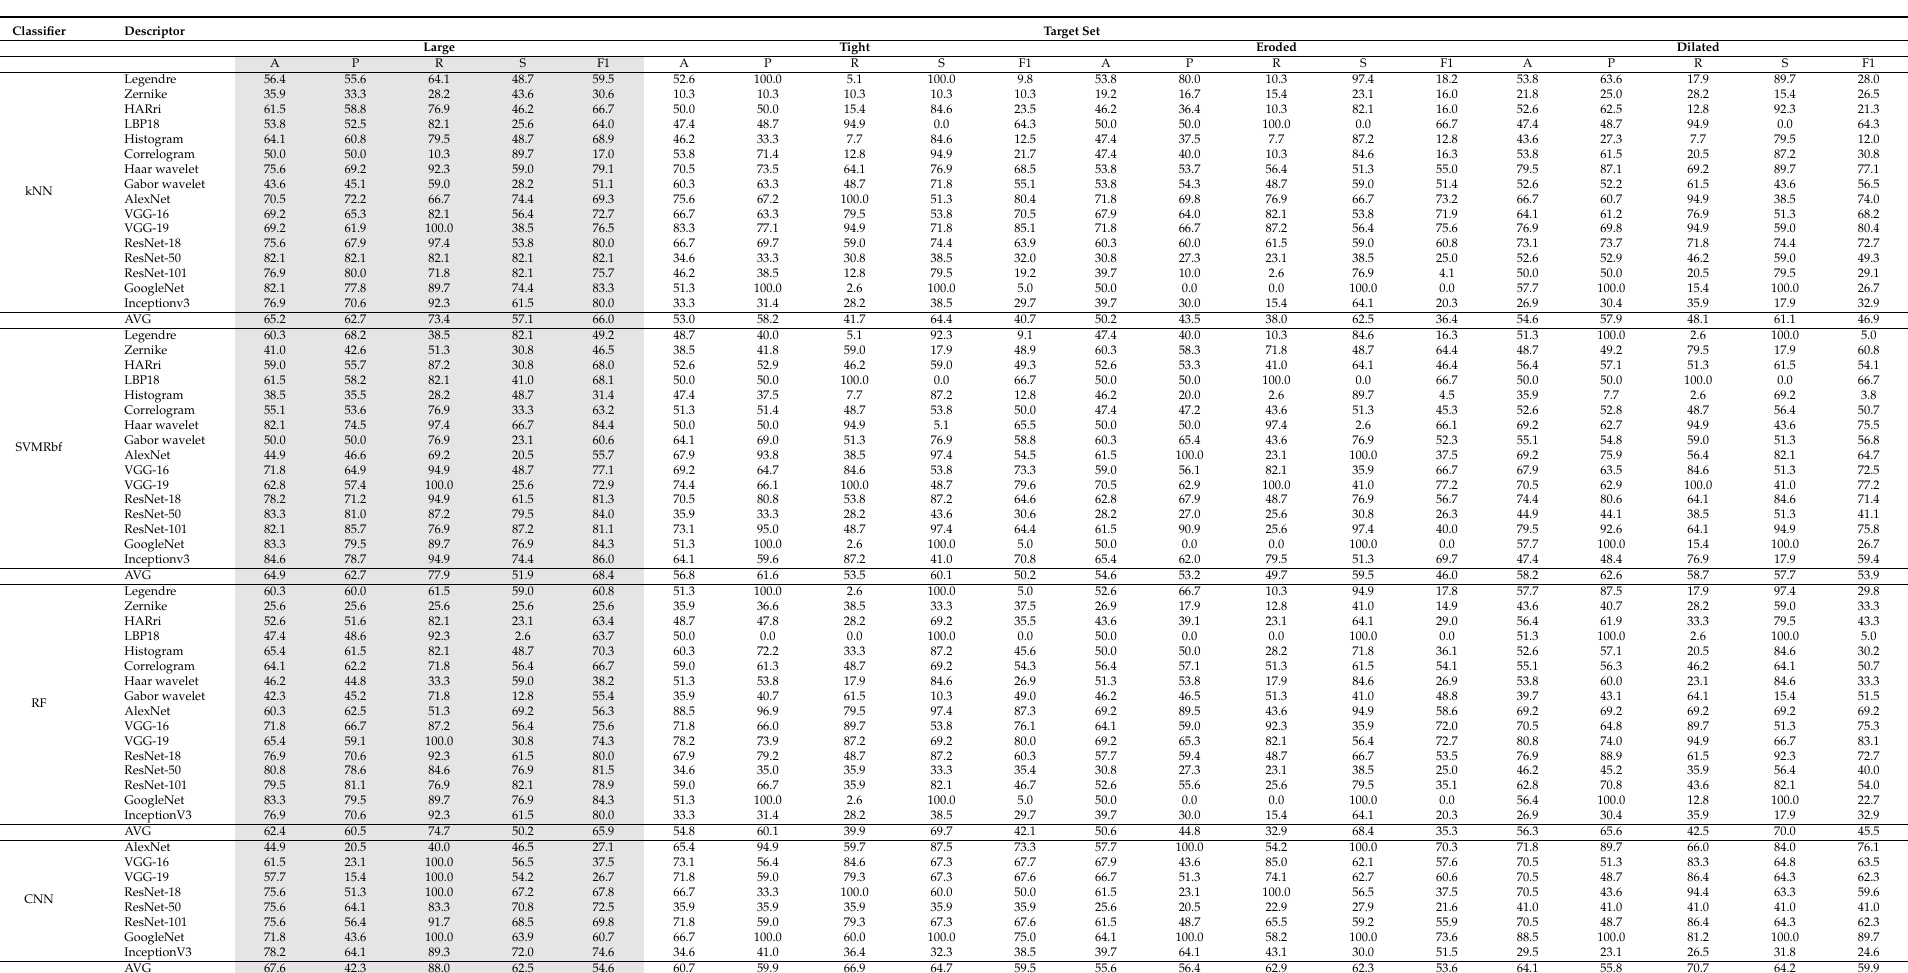
Table 2. ALL-IDB2 performance obtained with source models created exploiting the large data set version and tested using in turn (from the left) the large, tight, eroded and dilated versions. Same-version performance are highlighted in